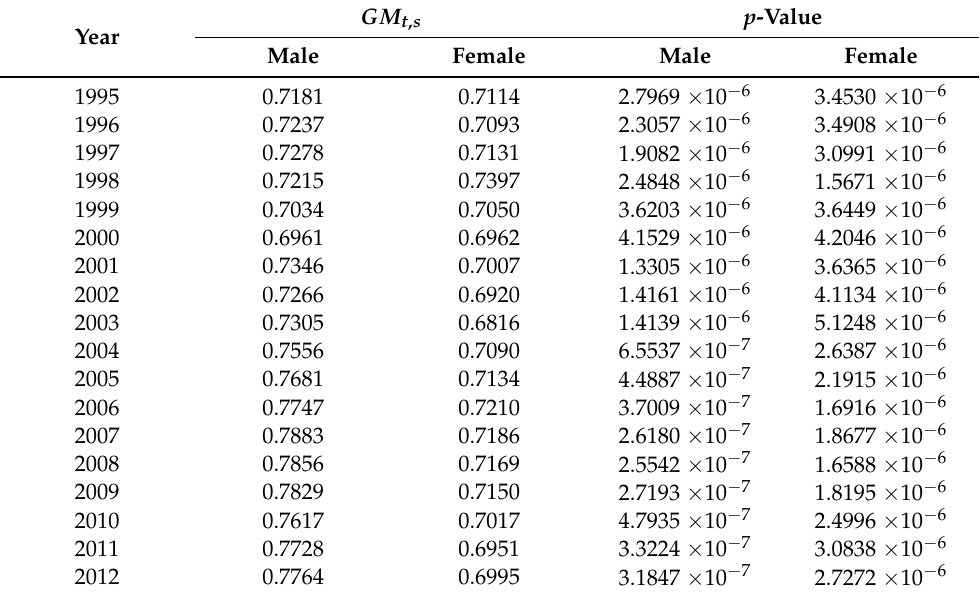
Table 1. Values of the Global Moran’s I and p -values by